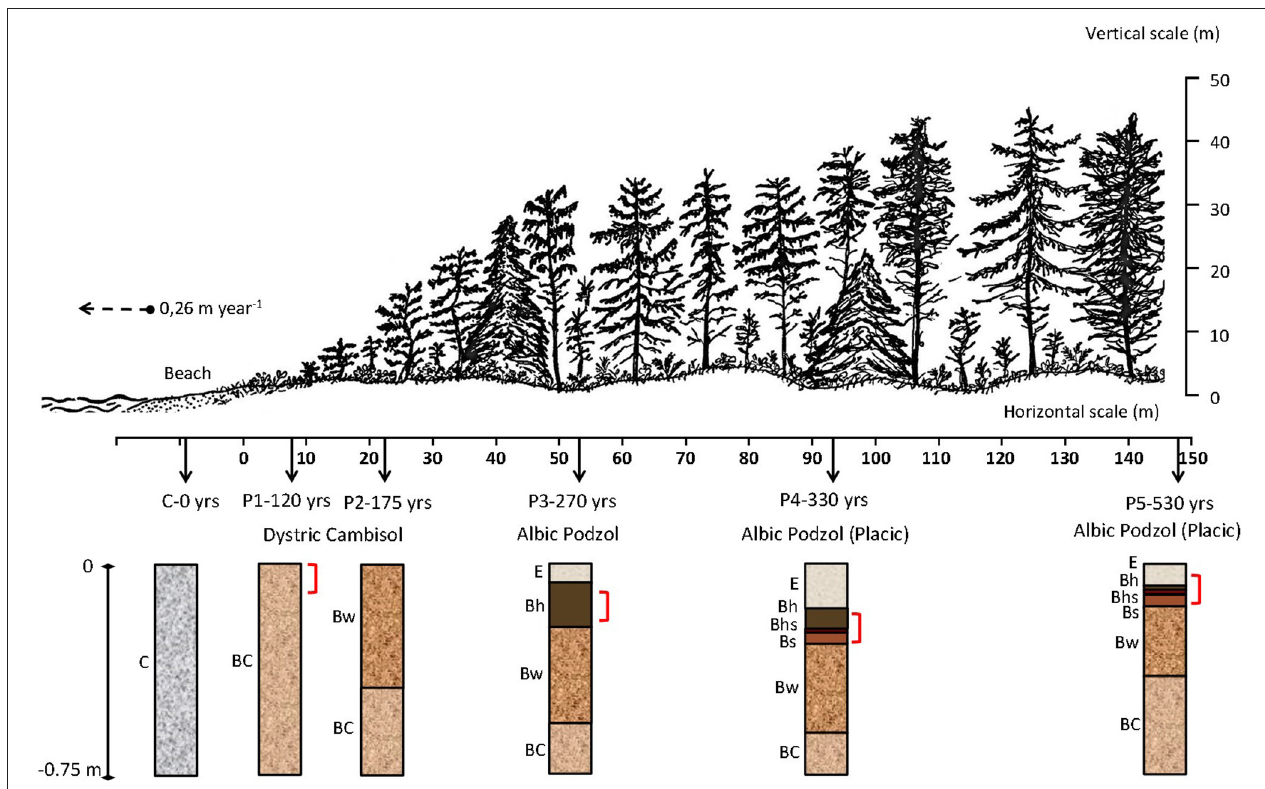
FIGURE 1 | Cross section of the Cox Bay chronosequence, showing site locations, soil horizons, depending on their respective age of soil formation: C-0 years, P1–120 years, P2–175 years, P3–270 years, P4–330 years, and P5–530 years and Kubiëna boxes location (shown in brackets) (modified from Vermeire et al., 2016).